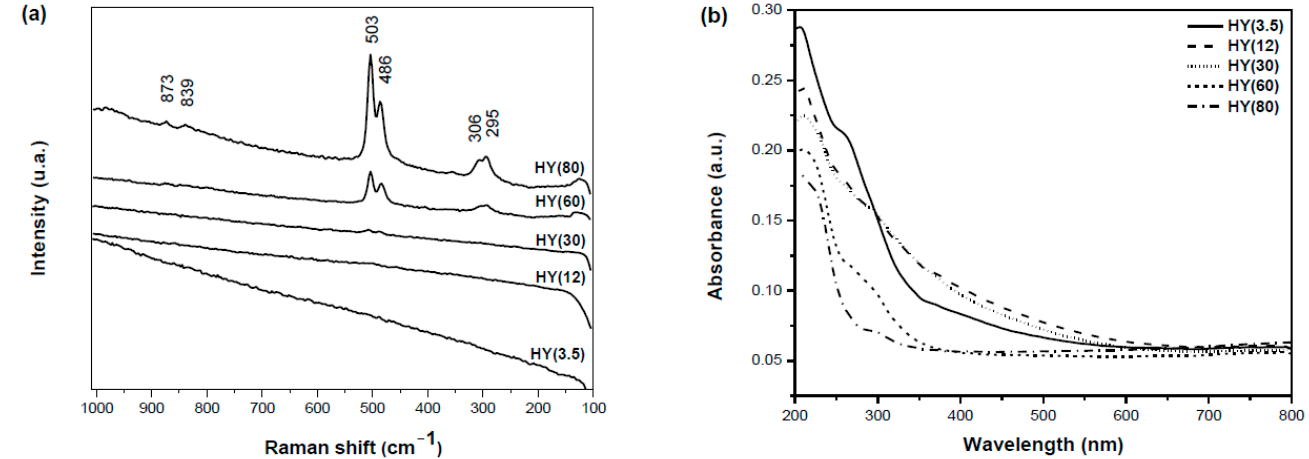
Figure 3. ( a ) Raman and ( b ) UV-vis spectra of the HY zeolites. The UV-vis spectra of the zeolites are shown in Figure 3b. The samples HY(3.5), HY(12), HY(30), HY(60) and HY(80) presented a main band at 260, 283, 285 280 and 280 nm, respectively, decreasing the absorbance with the decrease in the aluminum content.